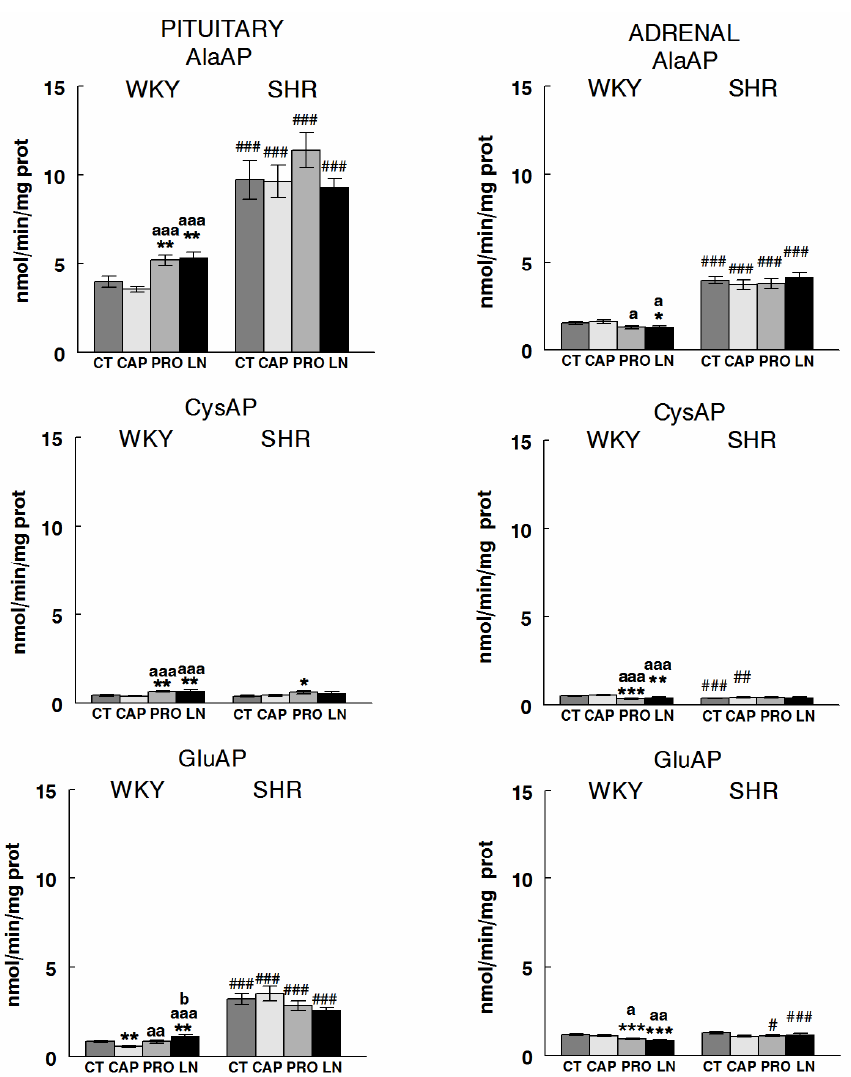
Figure 3. Influence of treatments on angiotensinase activities in pituitary (PT) and adrenal (AD) glands of Wistar–Kyoto (WKY) and spontaneously hypertensive rats (SHR). Bars represent Mean ± SEM levels of alanyl-aminopeptidase (AlaAP), cystinyl aminopeptidase (CysAP) and glutamyl-aminopeptidase (GluAP) activities, expressed as nmol/min/mg of pro- teins, in non-treated animals (control, CT) or treated with captopril (CAP), propranolol (PRO) or L-NAME (LN). (*) differences vs. control; (a) differences vs. CAP; (b) differences vs. PRO; (#) differences between strains. Single sign or letter (*, #, a, b, p < 0.05); double sign or letter (**, ##, aa, p < 0.01); triple sign or letter (***, ###, aaa, p < 0.001).